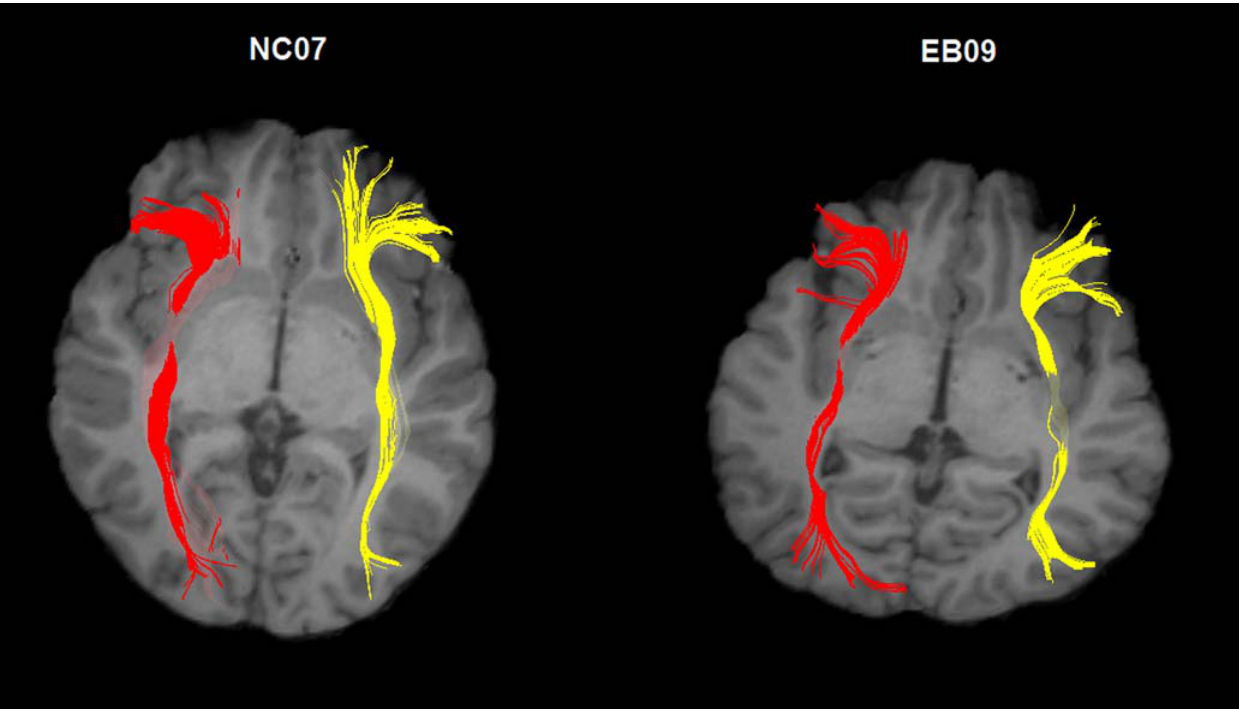
Figure 5. Representation of the reconstructed IFO fasciculi for a normal and blind subject. The tracked fibers are overlaied on the individual’s anatomical image (T1-weighted). Left: normal subject NC07; right: blind subject EB09.